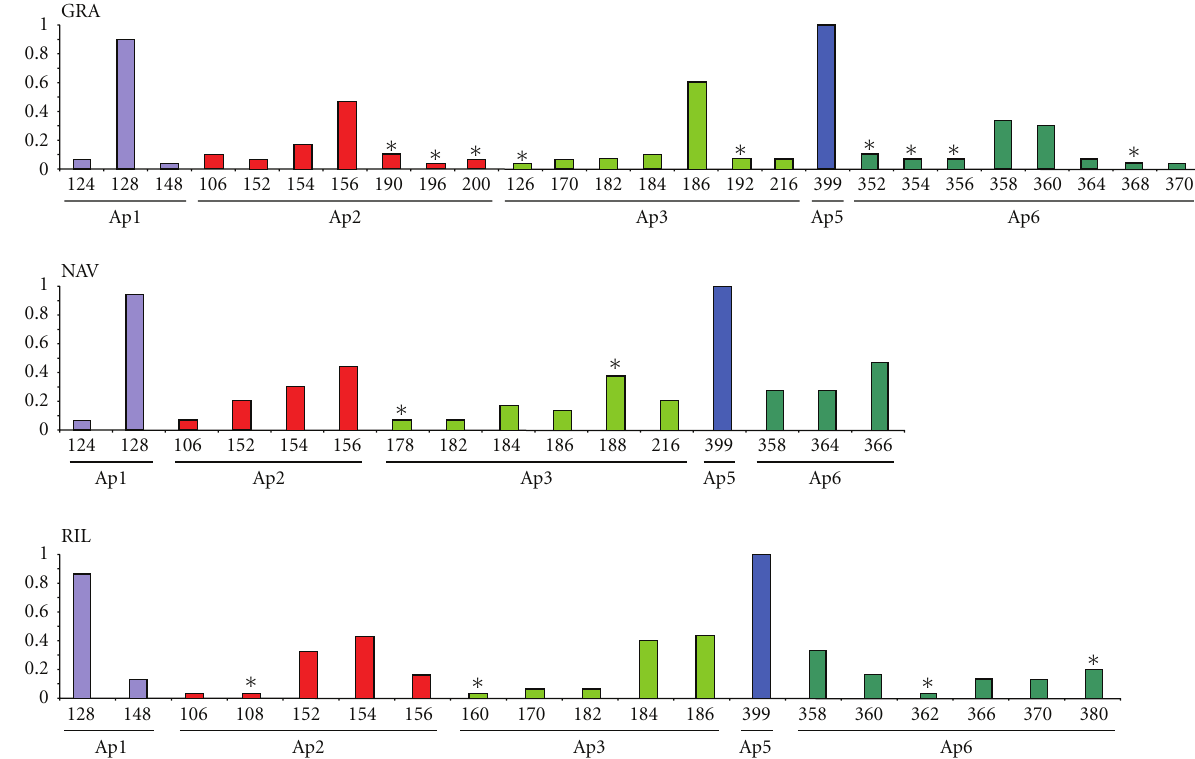
Figure 3: Allele frequencies in the populations of A. italicus for each microsatellite locus. Asterisk indicates private alleles. Table 3: Genetic variation for five microsatellite loci in three Spanish populations of A. italicus . % HW: % loci in Hardy-Weinberg equilibrium; A : mean number of observed alleles; n e : e ff ective number of alleles; H o : observed mean heterozygosity; H e : expected mean heterozygosity; F IS : inbreeding coe ffi cient.